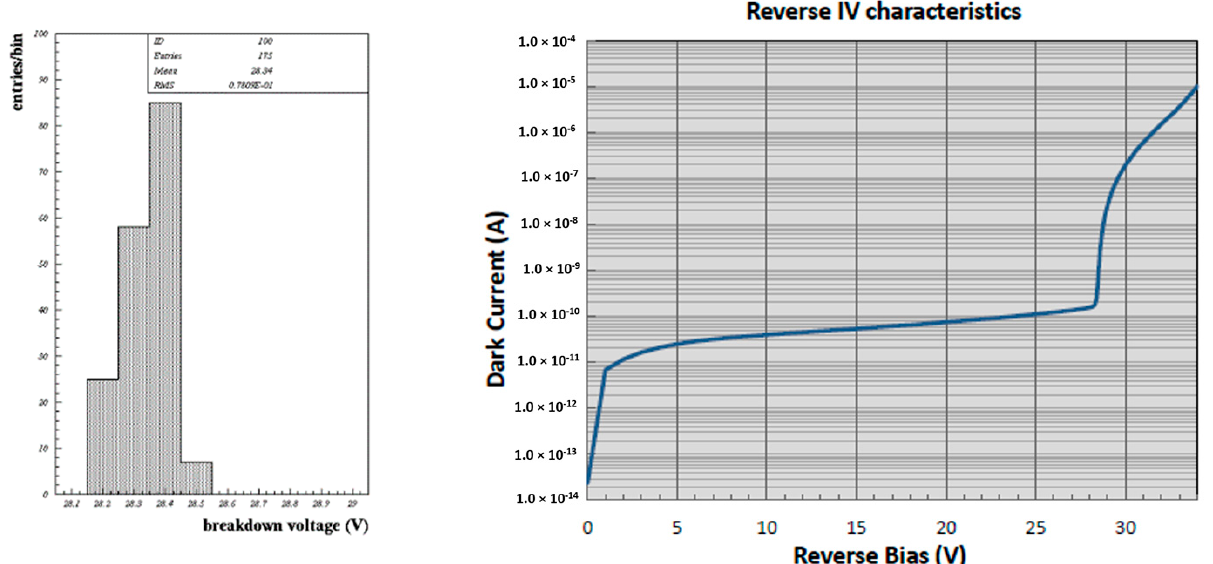
Figure 7. Left panel : Distribution of breakdown voltage for the SiPM used in the 1 mm pitch hodoscope. Right panel : Breakdown voltage curve for a typical Advansid ASD RGB SiPM.